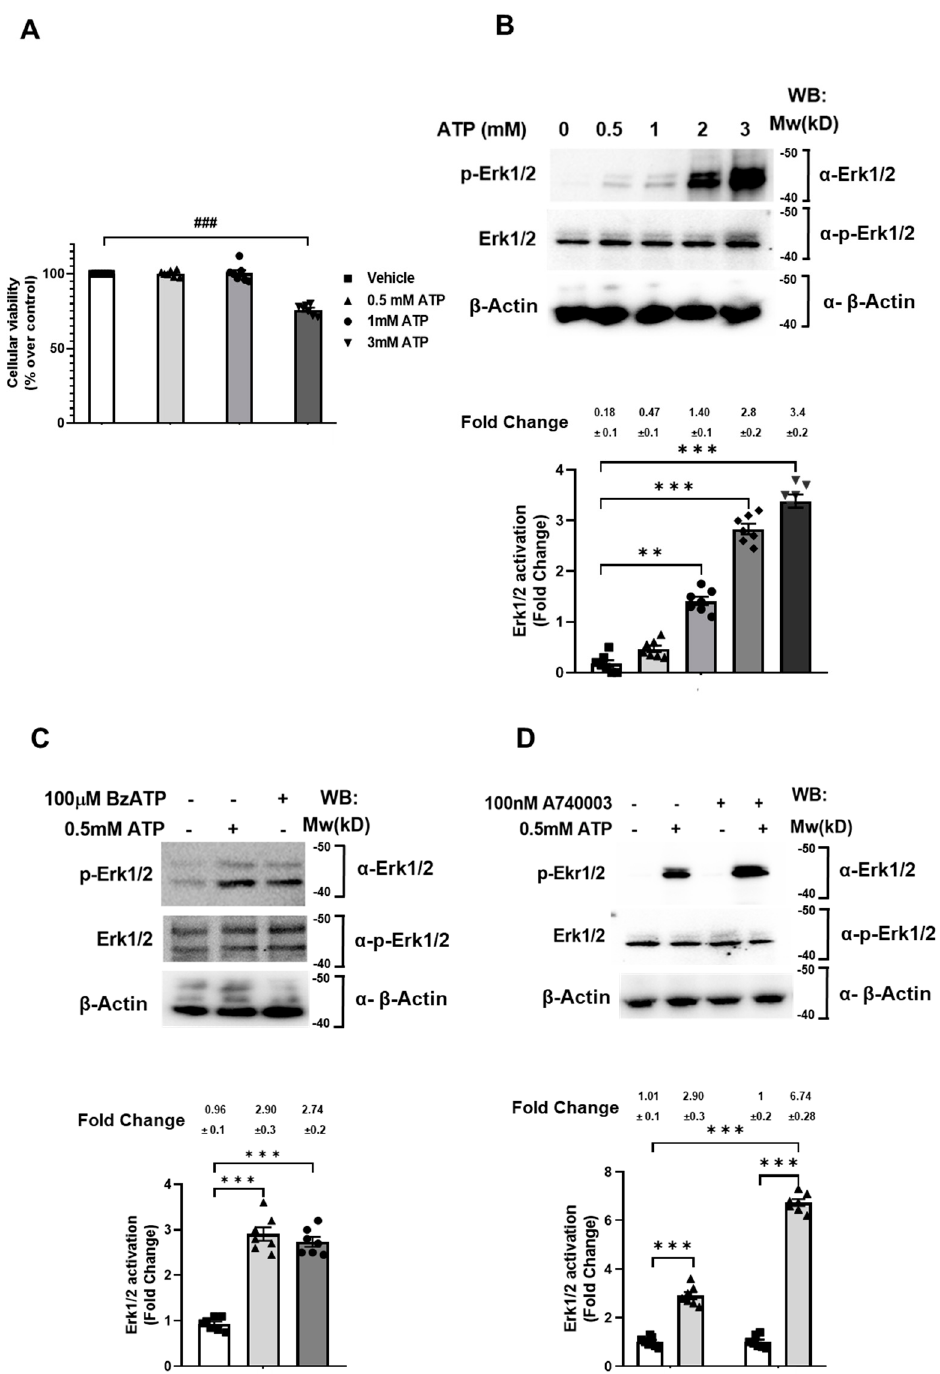
Figure 1. The ATP-stimulated P2X 7 receptor controls cellular viability and Erk1/2 phosphorylation in SN4741 cells. ( A ) SN4741 cells were serum-starved overnight and stimulated, or not, with different concentration of ATP for 5 min, and the cellular viability was measured by MTT assay. The values are represented as the percentage on control (untreated cells) and show the mean of five independent experiments ± SEM. SN4741 overnight-serum-starved cells were ( B ) stimulated, or not, with different concentrations of ATP for 5 min, ( C ) 0.5 mM ATP for 5 min or 100 µM BzATP for 10 min, ( D ) pre-treated with or without 100 nM A740003 (Table 1) for 1 h and, subsequently, stimulated, or not, with 0.5 mM ATP for 5 min, and lysed. Cell extracts were analyzed by Western blot using an anti-phospho-Erk1/2 antibody. The Erk1/2 amounts present in the samples analyzed were examined with an anti-Erk ½ antibody. The β -Actin amounts present in the samples analyzed in lower panel were examined with an anti- β -Actin antibody. Results show the mean of seven independent experiments ± SEM. Statistical analysis shows a significant difference (** p < 0.01, *** p < 0.001 and ### p < 0.001).